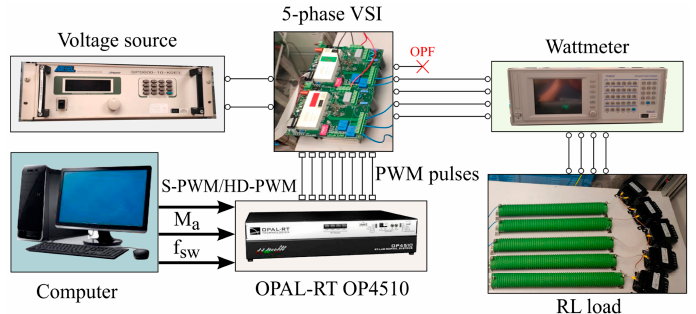
Figure 10. Experimental setup for the five-phase VSI under a single